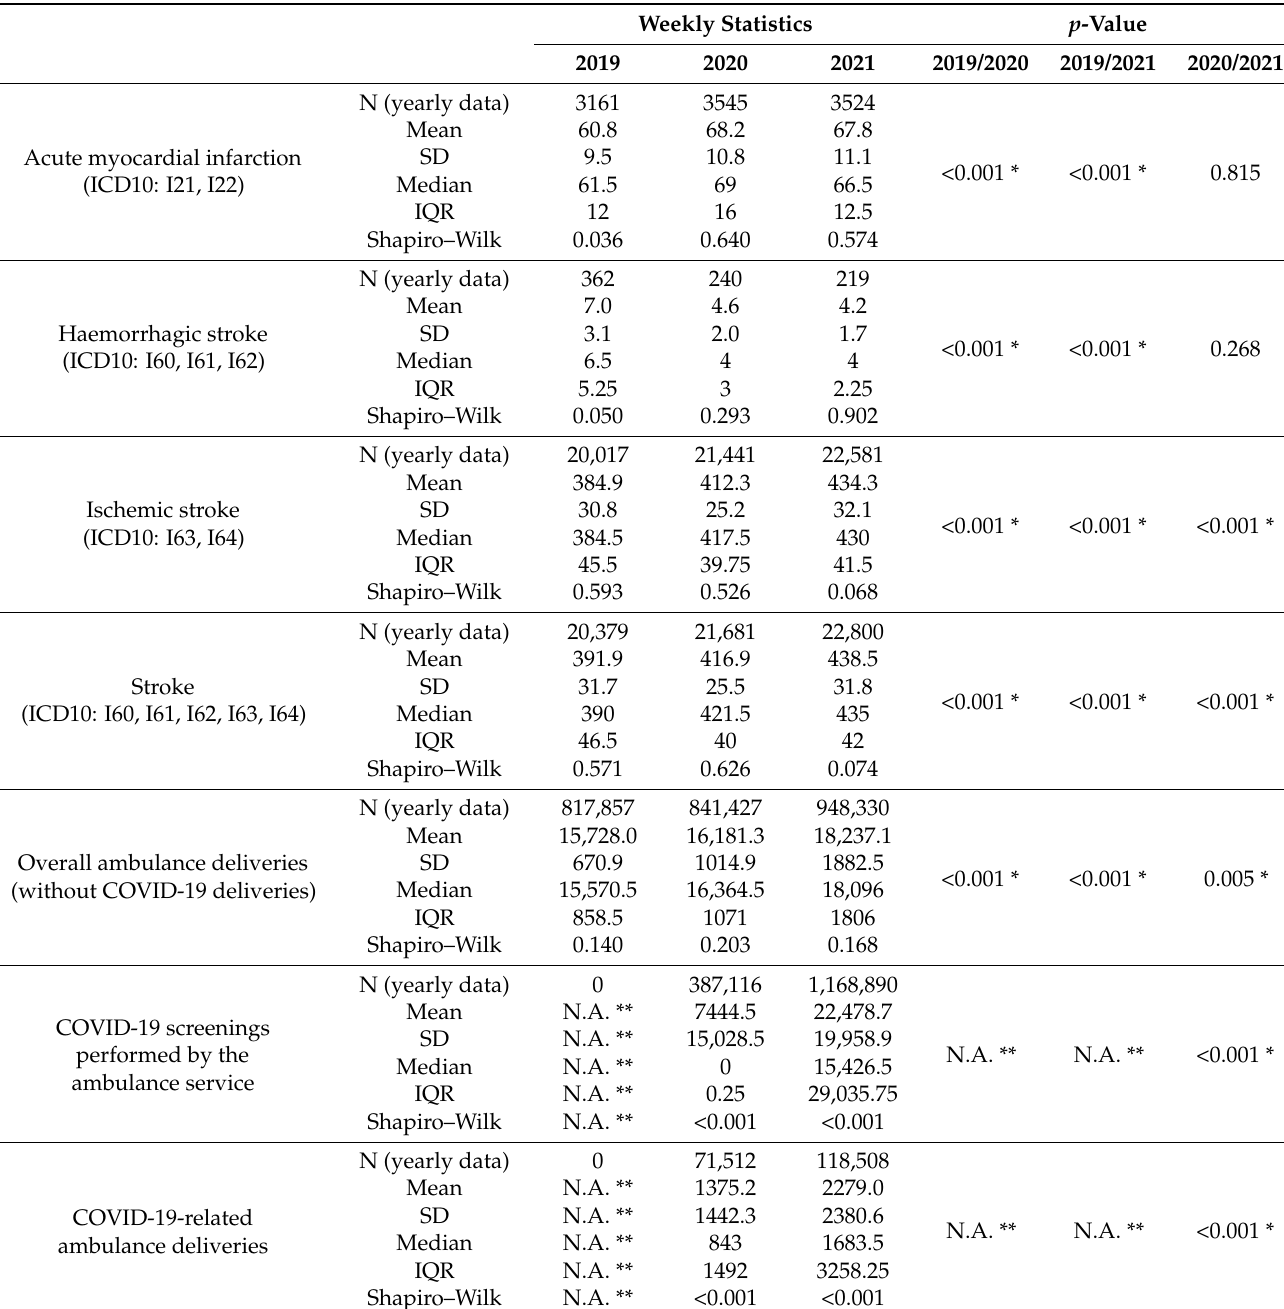
Table 3. Comparative analysis of COVID-19 screenings and various types of deliveries by the NAS between 2019 and